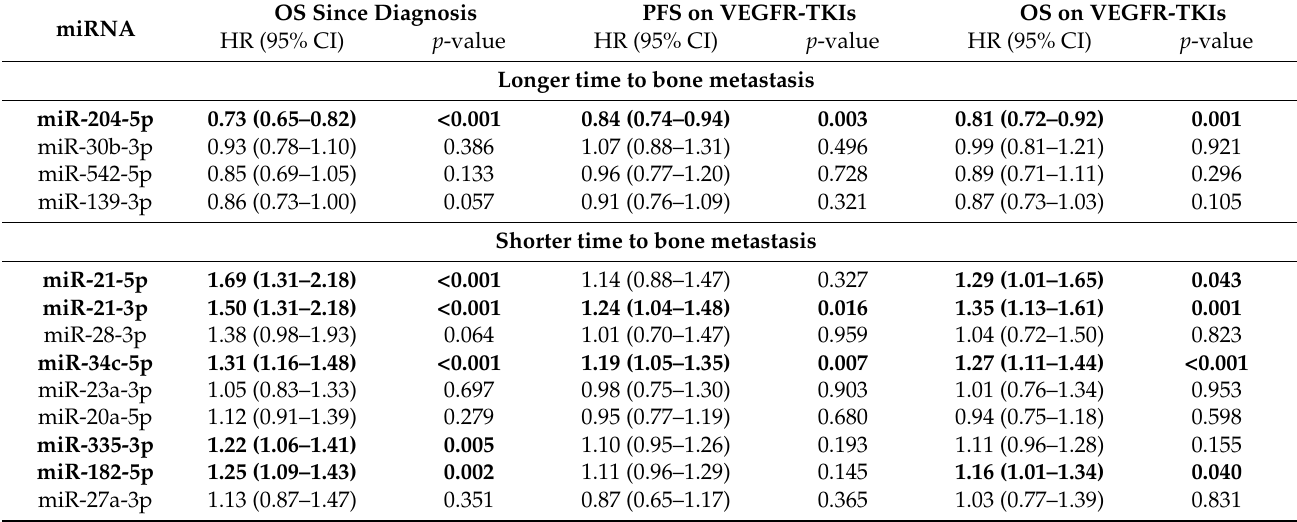
Table 4. Correlations of 13 miRNA involved in bone metastasis with OS since diagnosis and PFS and OS on 1st line VEGFR-TKI therapy (univariate Cox regression